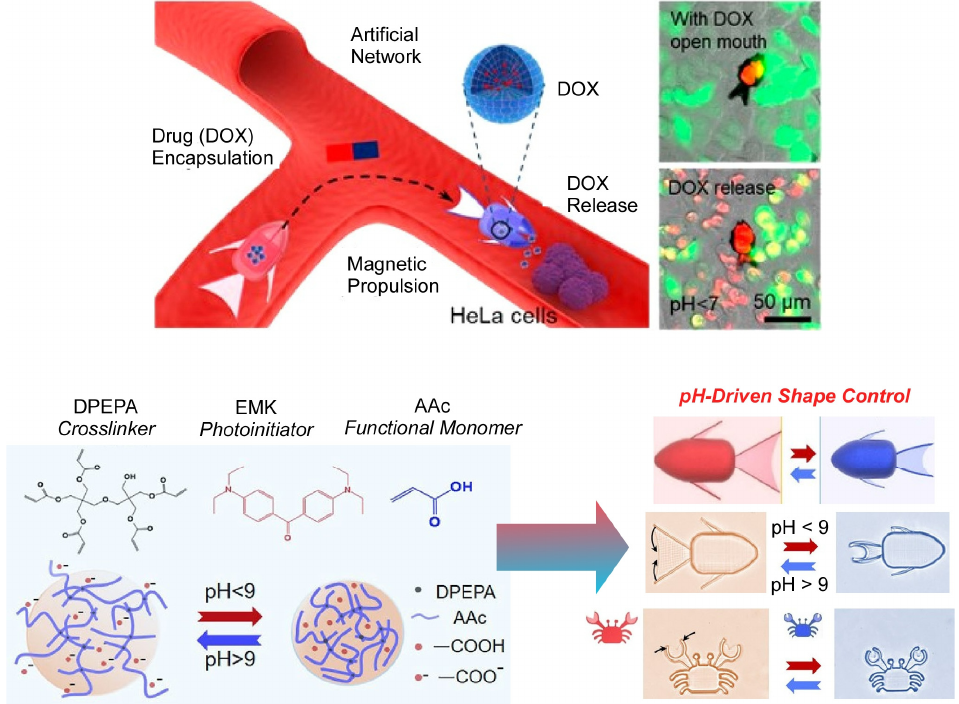
Figure 17. Environmentally adaptive shape-shifting microrobots for targeted delivery of micropar- ticles through grasping, transport, and release. Reprinted with permission from Reference [162]. Copyright 2021 American Chemical Society.